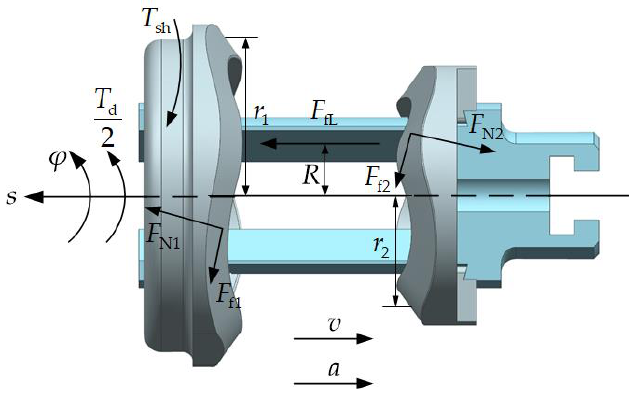
Figure 7. Force analysis of the cam rail set I.